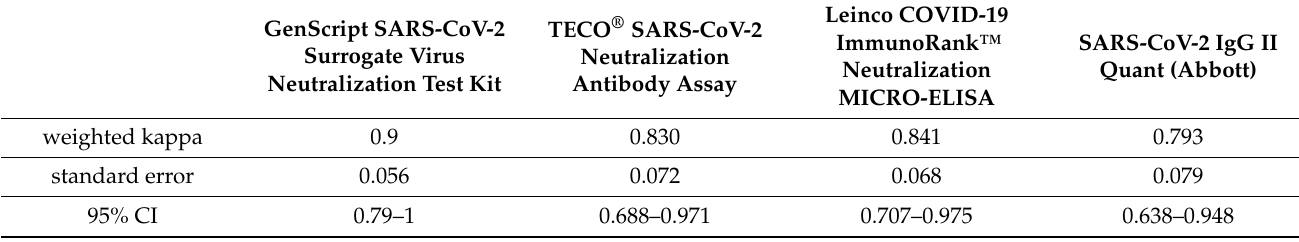
Table 2. Cohen’s weighted kappa coefficient between the examined SARS-CoV-2 antibody assays and PRNT